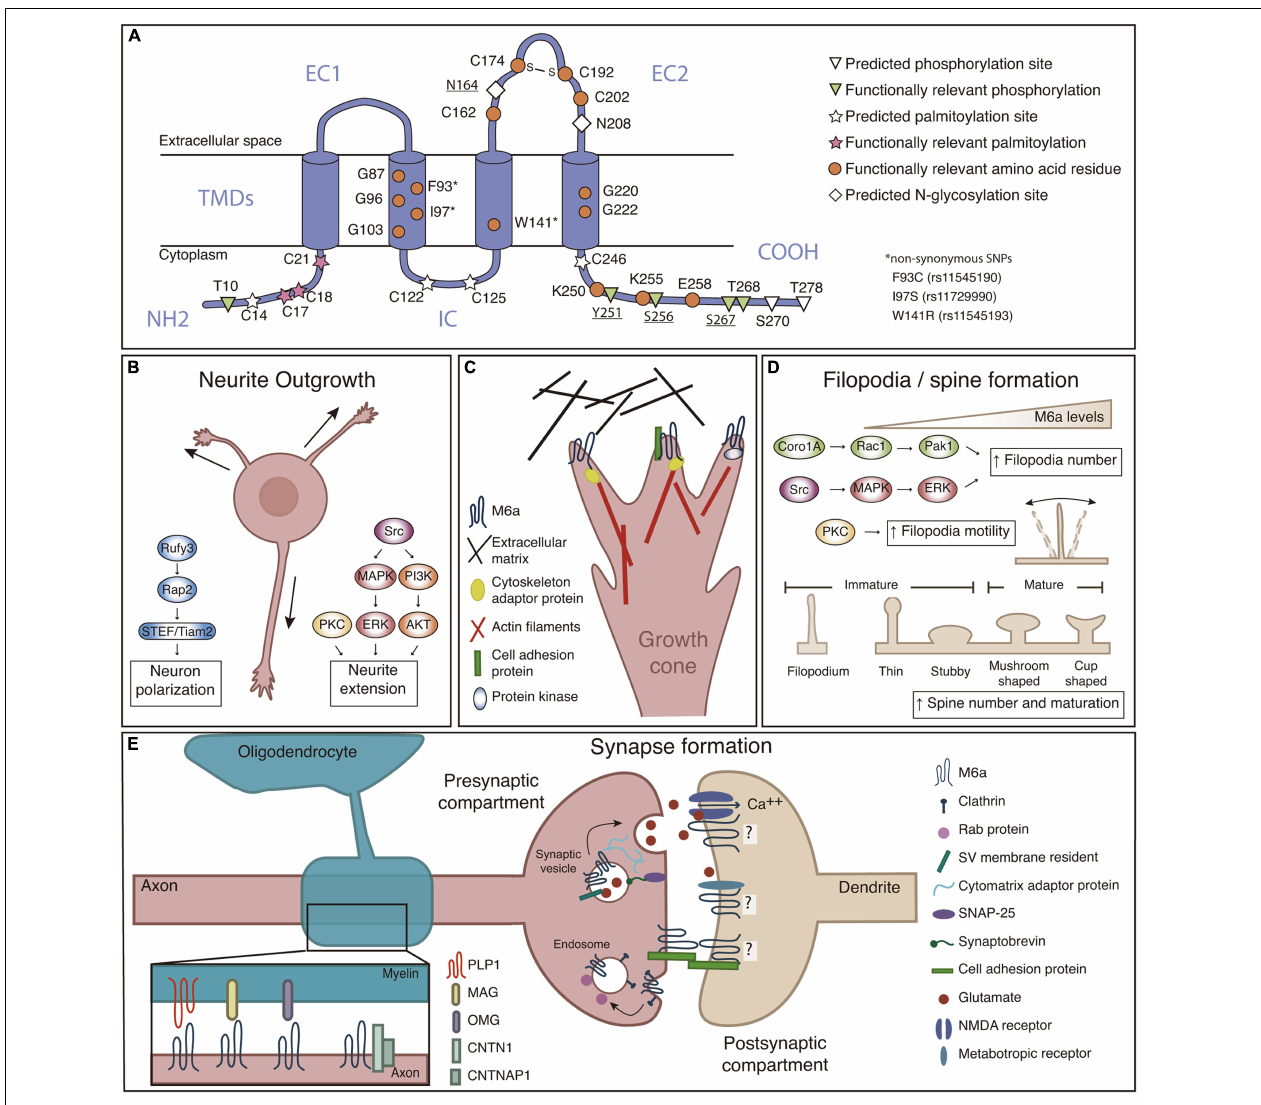
FIGURE 1 | (A) M6a structural features. M6a’s topological computational model predicts four transmembrane domains (TMDs), two extracellular loops (a small one—EC1- and a large one—EC2-), an intracellular loop (IC), and N- and C-terminal ends facing the cell cytoplasm (NH2 and COOH). Predicted sites for palmitoylation (C14, C17, C18, C21, C122, C125, and C246), N-glycosylation (N164 and N208), and phosphorylation (T10, Y251, S256, S267, T268, S270, and T278) are highlighted; bold underlined sites indicate post-translational modifications which are experimentally validated. Orange circles represent amino acid residues relevant for M6a function. (B) M6a promotes neurite outgrowth and neuronal polarization, which involves the activation of Src/MAPK/ERK, PKC and PI3K/AKT, and Rufy3-Rap2-STEF/Tiam2 signaling pathways, respectively. (C) We hypothesize that M6a function depends on its association with partner proteins in specific membrane microdomains. These associations, induce auto/phosphorylation in specific C-terminal residues facing the cytoplasm, and finally promote neuronal plasticity (Fuchsova et al., 2009; Scorticati et al., 2011; Formoso et al., 2015a,b; Garcia et al., 2017; Honda et al., 2017; Aparicio et al., 2020). For example, M6a can associate with extracellular matrix proteins such as brevican and tenascin C through its extracellular loops in trans and/or with cell adhesion proteins (NCAM and NPTN) through its extracellular domains in cis , triggering its phosphorylation and therefore the recruitment of adapter proteins (such as Rap) and the activation of protein kinases that finally promote the reorganization of the cytoskeleton. (D) M6a promotes filopodia formation and motility through a mechanism that involves the activation of the Coro1A/Rac1/Pak1 and Src/MAPK/ERK, and PKC pathways, respectively. M6a also participates in spine formation and maturation of dendritic protrusions. (E) Left: Recently proposed interactions between M6a and myelin sheath proteins (PLP1, MAG, and OMG), and myelinated-axon proteins CNTN1 and CNTNAP1. Right: M6a is located at the presynaptic compartment plasma membrane, synaptic vesicle—SV—and endosomal membranes. M6a also interacts with postsynaptic glutamate receptors (like NMDA-R1 and GRM1) but its localization to the postsynaptic compartment was not experimentally confirmed yet. M6a, glycoprotein M6a; Src, Src kinase; MAPK, mitogen-activated protein kinase; ERK, extracellular signal-regulated kinase; PKC, protein kinase C; PI3K, phosphatidylinositide 3-kinase; AKT, serine/threonine-protein kinase; Rap2, Ras-related protein-2; Rufy3, Rufy 3 protein; STEF/Tiam2, T-lymphoma invasion and metastasis-inducing protein 2; NCAM, Neural cell adhesion molecule; NPTN, neuroplastin; Coro1A, coronin-1A; Rac1, Ras-related C3 botulinum toxin substrate 1; Pak1, p21-activated kinase 1; PLP1, proteolipid protein 1; MAG, myelin-associated glycoprotein; OMG, oligodendrocyte-myelin glycoprotein; CNTN1, contactin-1; CNTNAP1, contactin-associated protein 1; NMDA-R1, N-methyl-D-aspartate receptor 1; GRM1, metabotropic glutamate receptor 1; SNAP25, Synaptosomal-Associated Protein, 25